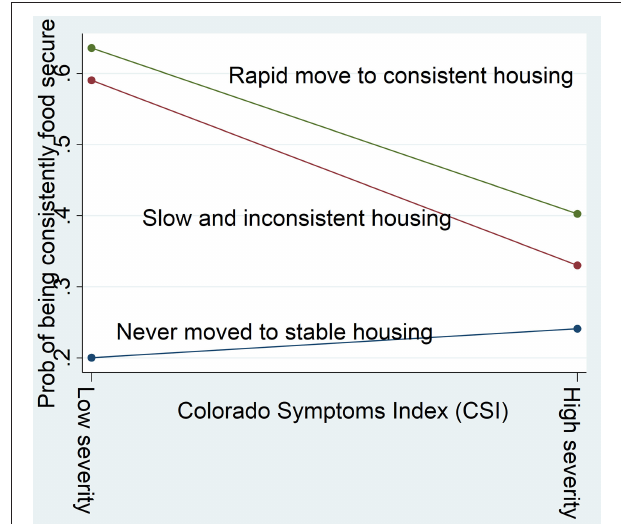
FIGURE 3 | Substance use disorders modify the effect of housing trajectory on food